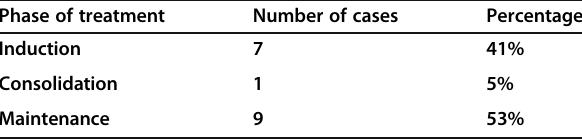
Table 3 Distribution of cases with cerebral venous thrombosis regarding phase of